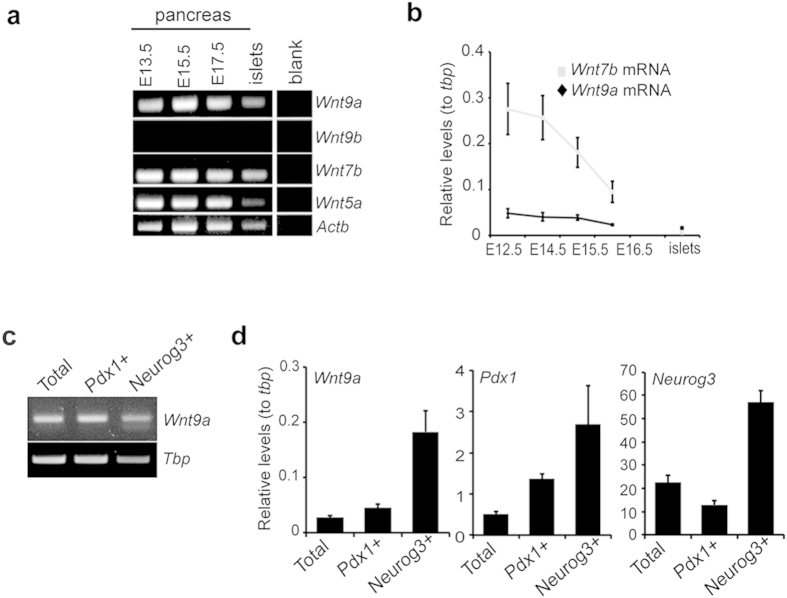
Expression of Wnt9a in the embryonic pancreas.(a) Total RNA was extracted from mouse embryonic pancreases at the indicated stages and from adult isolated mouse islets. mRNAs encoding the indicated genes were assayed by conventional RT-PCR. Note that expression of both Wnt5a and Wnt7b had been previously identified in the developing pancreas and are included for comparison purposes. Cycles used were 25 for Actb and 35 for the other genes. Representative gel image is shown. Lane showing non-template control for each transcript (blank) was run under the same experimental conditions. (b) Wnt9a and Wnt7b mRNA levels were quantitated by qRT-PCR and expressed relative to tbp gene expression. Each point represents mean ± SEM for at least 3 independent determinations. (c) Representative gel showing expression of Wnt9a mRNA in E15.5 total pancreas, in FACS-purified Tomato+ (Pdx1+, epithelial) cells obtained from E14.5 pancreas of Pdx1-Cre; Rosa26: tdTomato and in FACS-purified Tomato+ (Neurog3+, endocrine) cells obtained from E15.5 pancreas of Neurog3-Cre; Rosa26: tdTomato. (d) Quantification of Wnt9a, Neurog3 and Pdx1 mRNA levels in total RNA from samples prepared as detailed in (c). Values are expressed relative to tbp mRNA levels in each sample. Bars represent mean ± SEM for at least 5 independent sorting experiments.